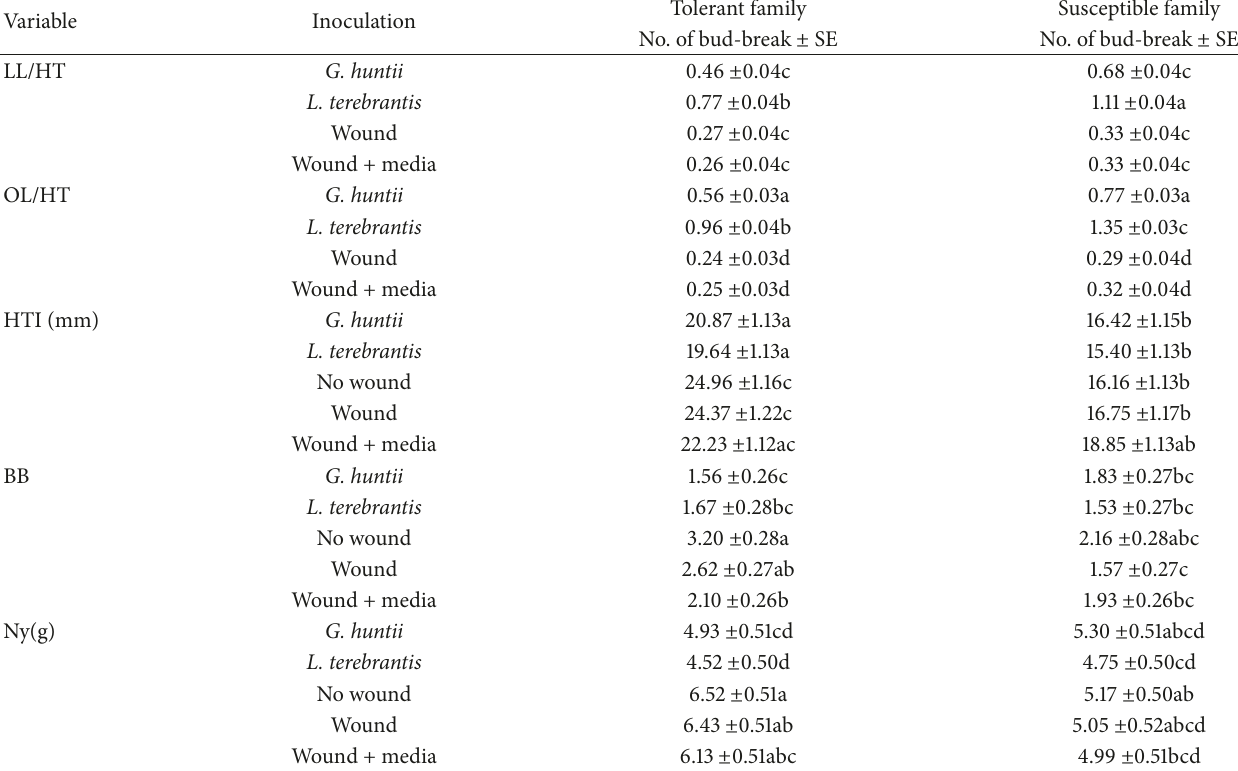
Table 6: Least square means and standard errors of number of various response variables in tolerant and susceptible family receiving various inoculations.